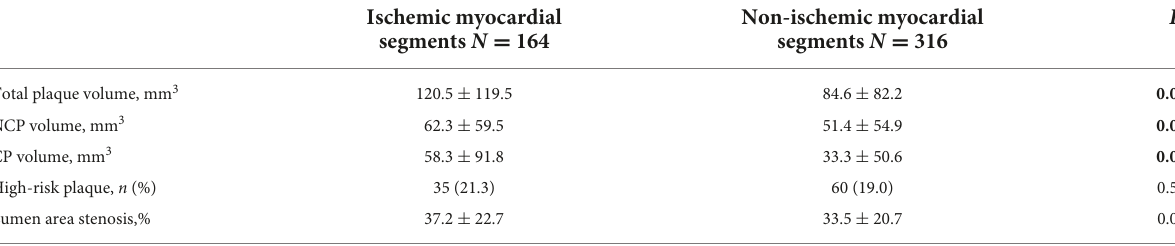
TABLE 2 Coronary plaque characteristics in ischemic and non-ischemic myocardial segments.